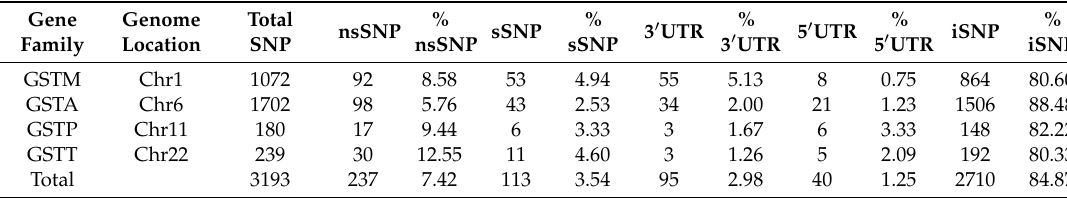
Table 1. Major types of GST genes and their SNP distributions (based on